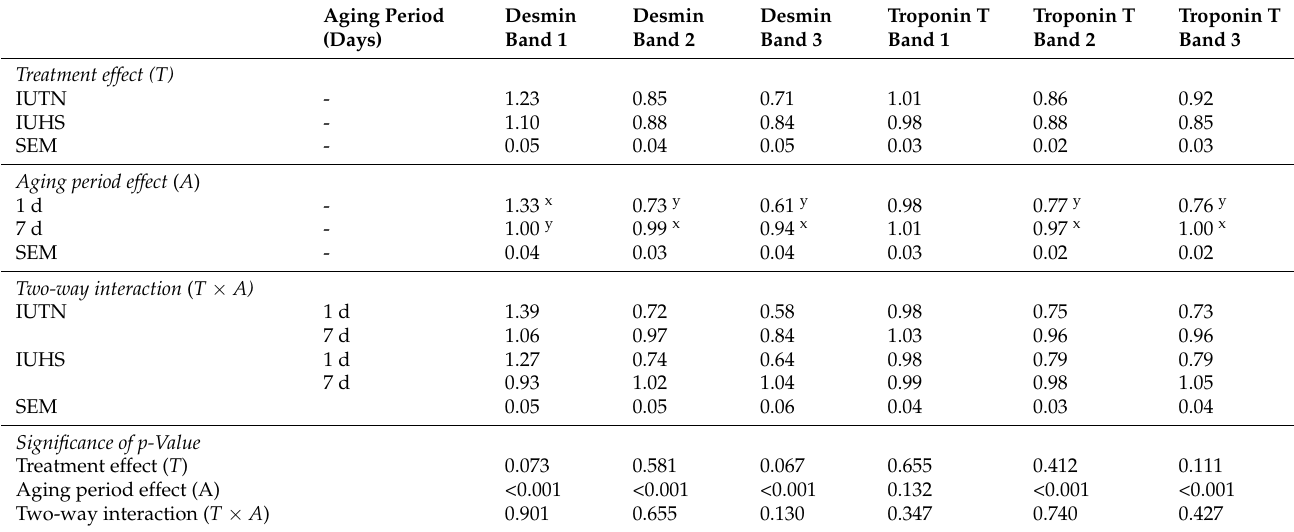
Table 5. Main and interactive effects of IUHS treatment and postmortem aging duration on relative abundance of desmin and troponin T ( n = 10/treatment).